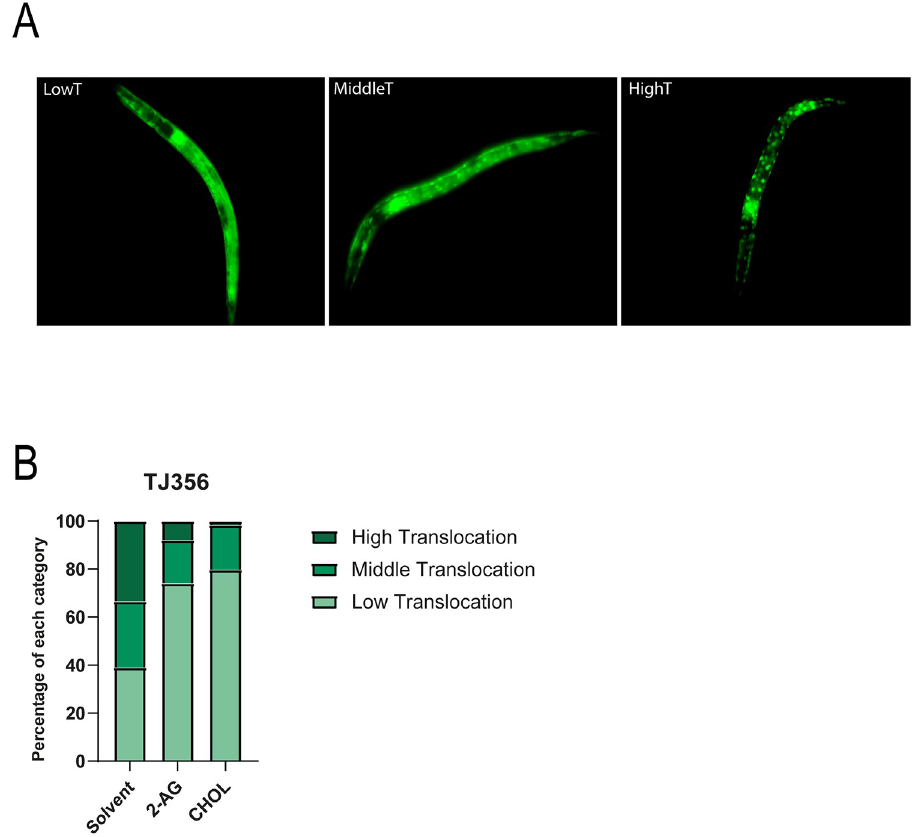
Fig 7. 2-AG signaling inhibits nuclear translocation of DAF-16 induced by cholesterol depletion. (A) DAF-16:: GFP nuclear translocation group classification. Translocation categories were placed into 3 classes as shown in the picture. Animals which exhibited DAF-16::GFP nuclear accumulation between 0–10% of total DAF-16::GFP were classified as Low Translocation (LowT), 30–50% as Middle Translocation (MiddleT) and 70–90%, High Translocation (HighT). All animals shown are in a L2 larva stage. (B) Nuclear translocation of DAF-16::GFP in worms grown under normal cholesterol concentration (CHOL) and after cholesterol depletion for two generations in the absence (solvent) or presence of 2-AG. 69 individual worms were analyzed for the solvent condition, 66 for 2-AG and 64 for CHOL.